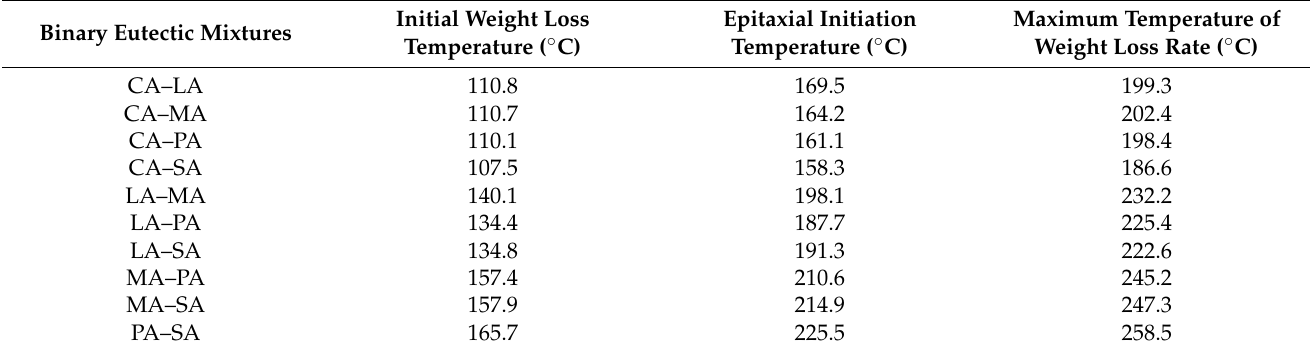
Table 6. Thermal stability parameters of ten fatty acid binary eutectic mixtures.